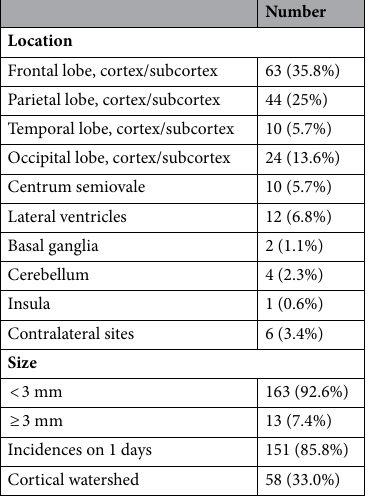
Table 2. Distribution of new DWI lesions in patients receiving CAS.